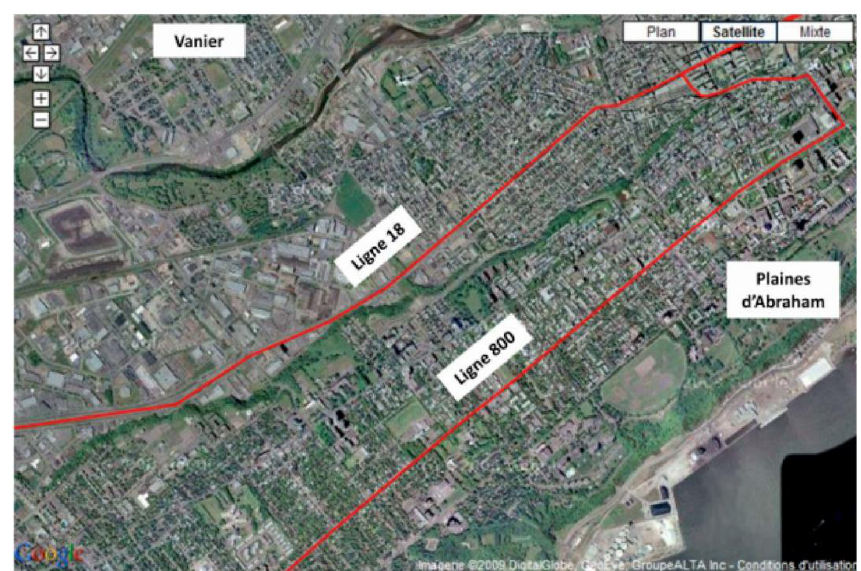
Figure 6. Initial situation.